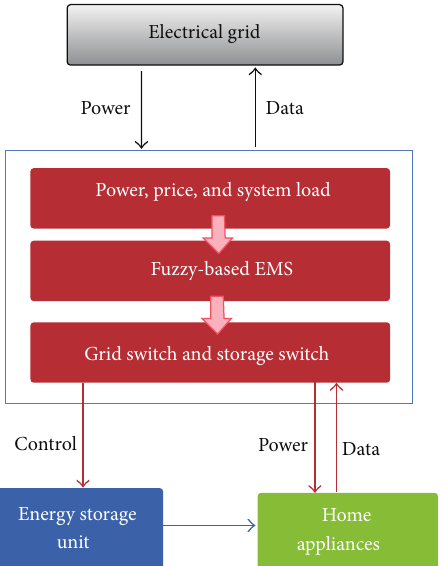
Figure 3: Fuzzy-based inference system for energy management system.